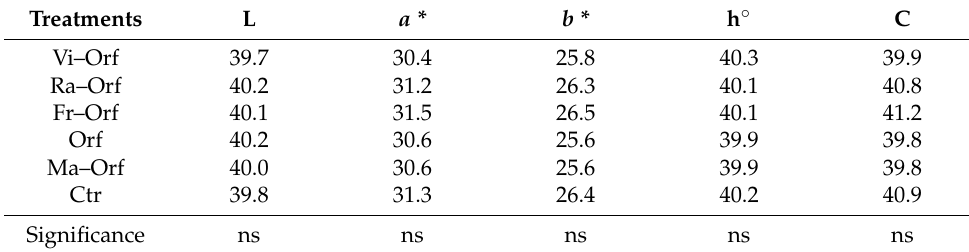
Table 3. Effects of treatments on color parameters (L, a* , b* , h ◦ , and C) of tomato fruits. Treatments L